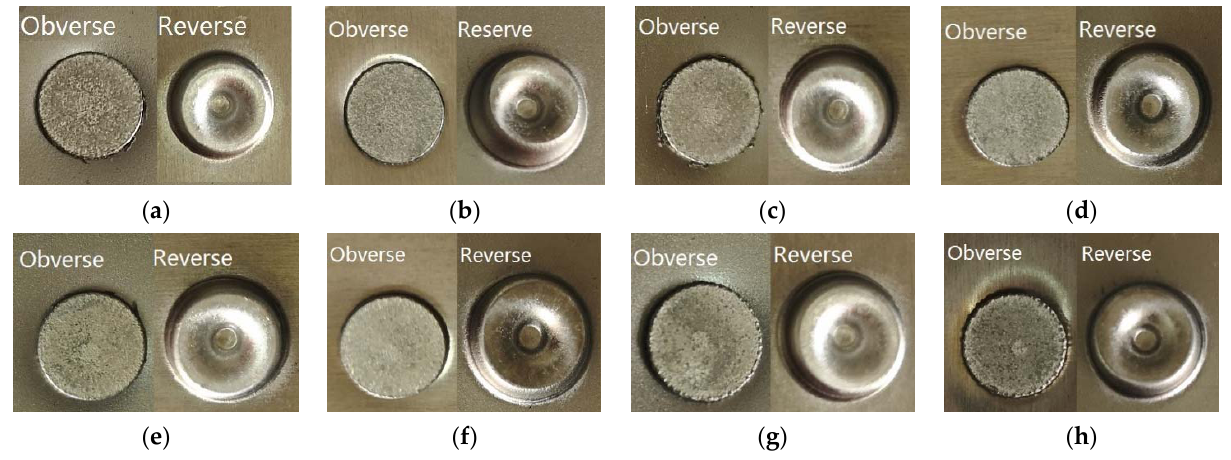
Figure 3. Surfaces of SPR joints: ( a ) SPFC ‐ AA joint with 6 mm rivet; ( b ) AA ‐ SPFC joint with 6 mm rivet; ( c ) SPFC ‐ AA joint with 7 mm rivet; ( d ) AA ‐ SPFC joint with 7 mm rivet; ( e ) SPFC ‐ AA joint with rivet; ( c ) SPFC-AA joint with 7 mm rivet; ( d ) AA-SPFC joint with 7 mm rivet; ( e ) SPFC-AA joint with 8 mm rivet; ( f ) AA ‐ SPFC joint with 8 mm rivet; ( g ) SPFC ‐ AA joint with 9 mm rivet; ( h ) AA ‐ SPFC 8 mm rivet; ( f ) AA-SPFC joint with 8 mm rivet; ( g ) SPFC-AA joint with 9 mm rivet; ( h ) AA-SPFC joint with 9 mm rivet. joint with 9 mm rivet.